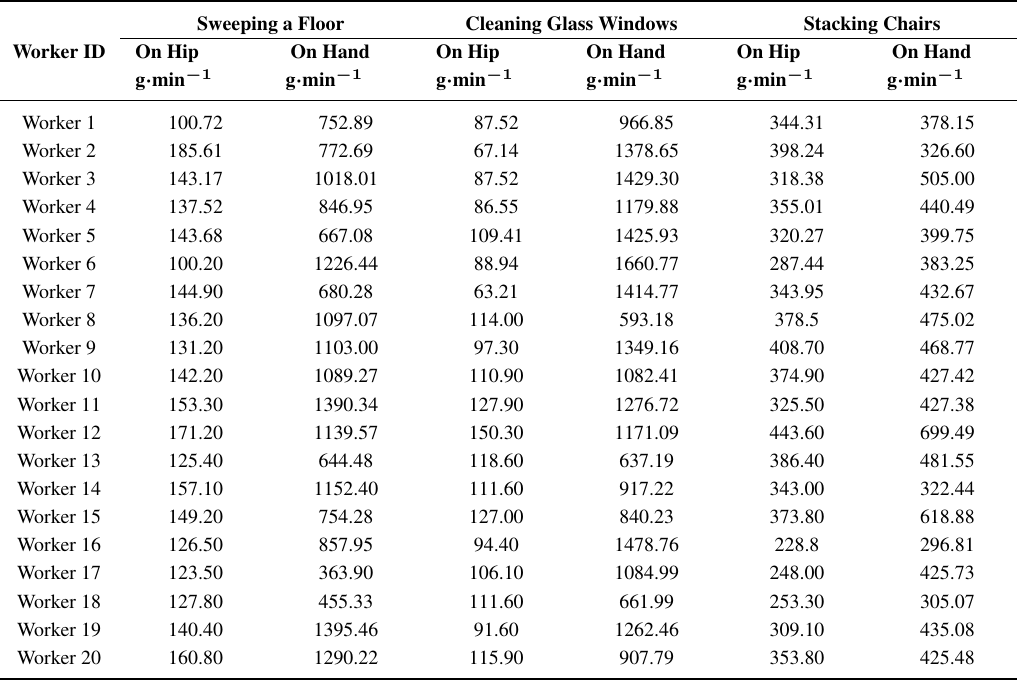
Table 7. Results obtained using the Samsung S4 accelerometer.